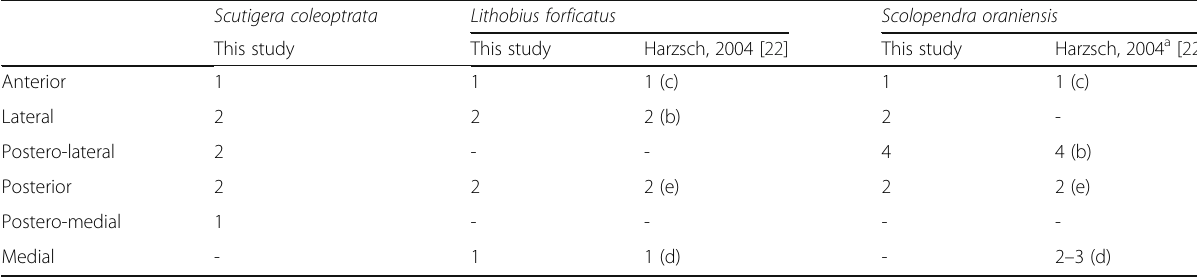
Table 1 Number and position of 5HT-ir neurons in a hemiganglion of Chilopoda Scutigera coleoptrata Lithobius